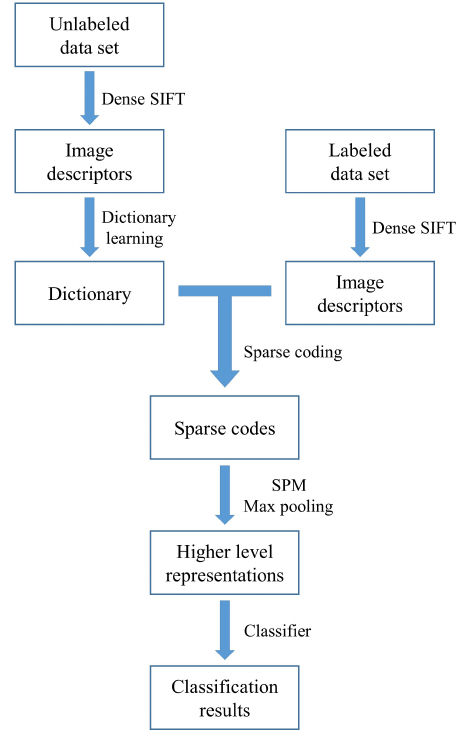
Figure 1. Flowchart of